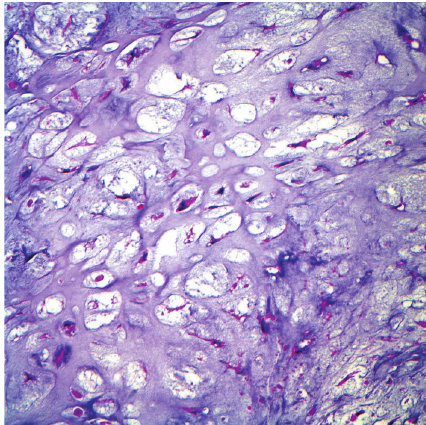
Figure 1: Photomicrograph of grade I chondrosarcoma, demon- strating abundant extracellular hyaline matrix and scant cellularity (Courtesy of Robert S. Beissner MD, PhD, Department of Pathol- ogy, Scott & White Memorial Hospital and Clinic, Temple, TX,